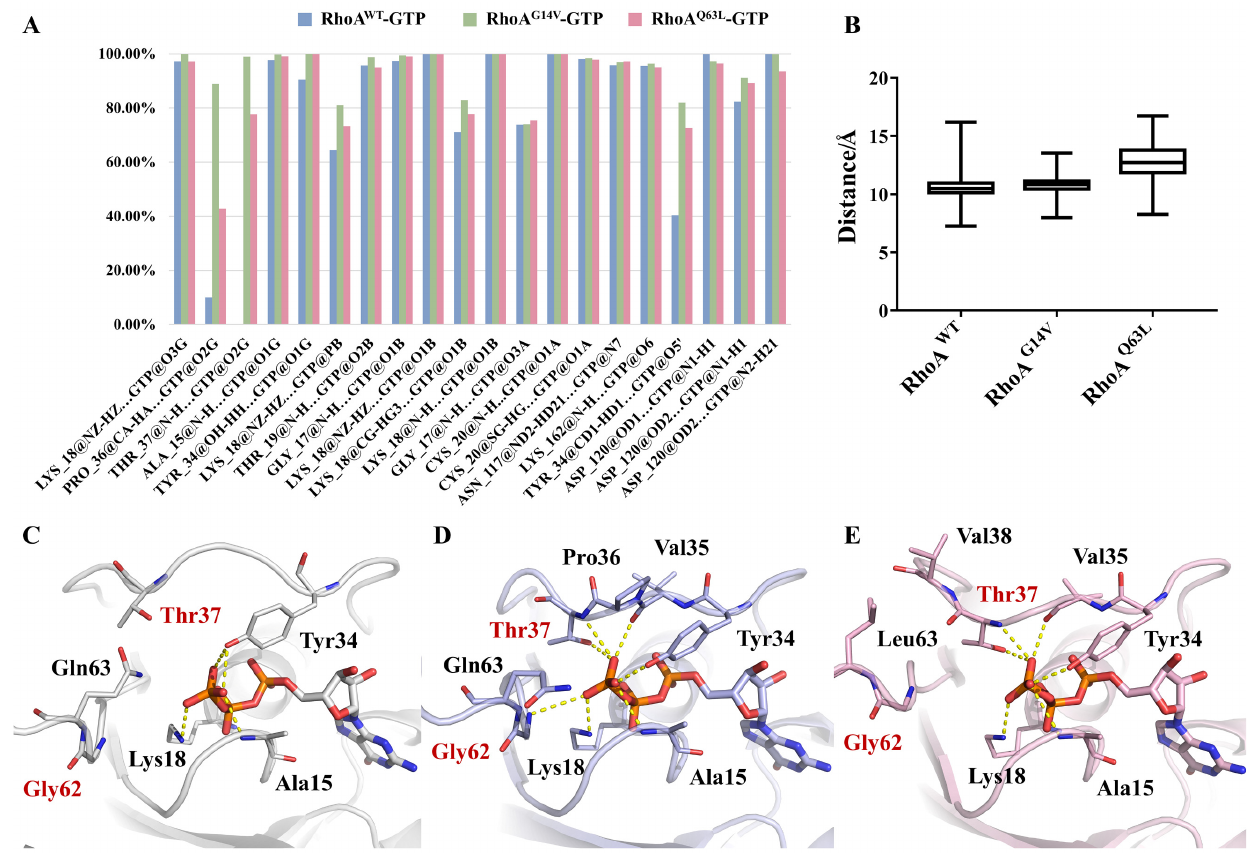
Figure 5. Interactions between GTP and RhoA WT , RhoA G14V , and RhoA Q63L . ( A ) Fractions of hydrogen bonds formed between GTP and RhoA. The fractions shown here are averaged over each system ʹ s last 120 ns of the triple runs. ( B ) Distances from the C δ atom of Q63 (or L63) to the P β atom of GTP in different systems during the simulations. ( C – E ) Close ‐ up on the nucleotide ‐ binding site of complexes RhoA WT ‐ GTP ( C , gray), RhoA G14V ‐ GTP ( D , light blue), and RhoA Q63L ‐ GTP ( E , light pink). All the structures used here are the middle structures of the most populated clusters of each system obtained by clustering analysis. Crucial residues are labeled and shown as sticks (colored by element), with the γ‐ phosphate ‐ mediated hydrogen bonds indicated as yellow dotted lines.